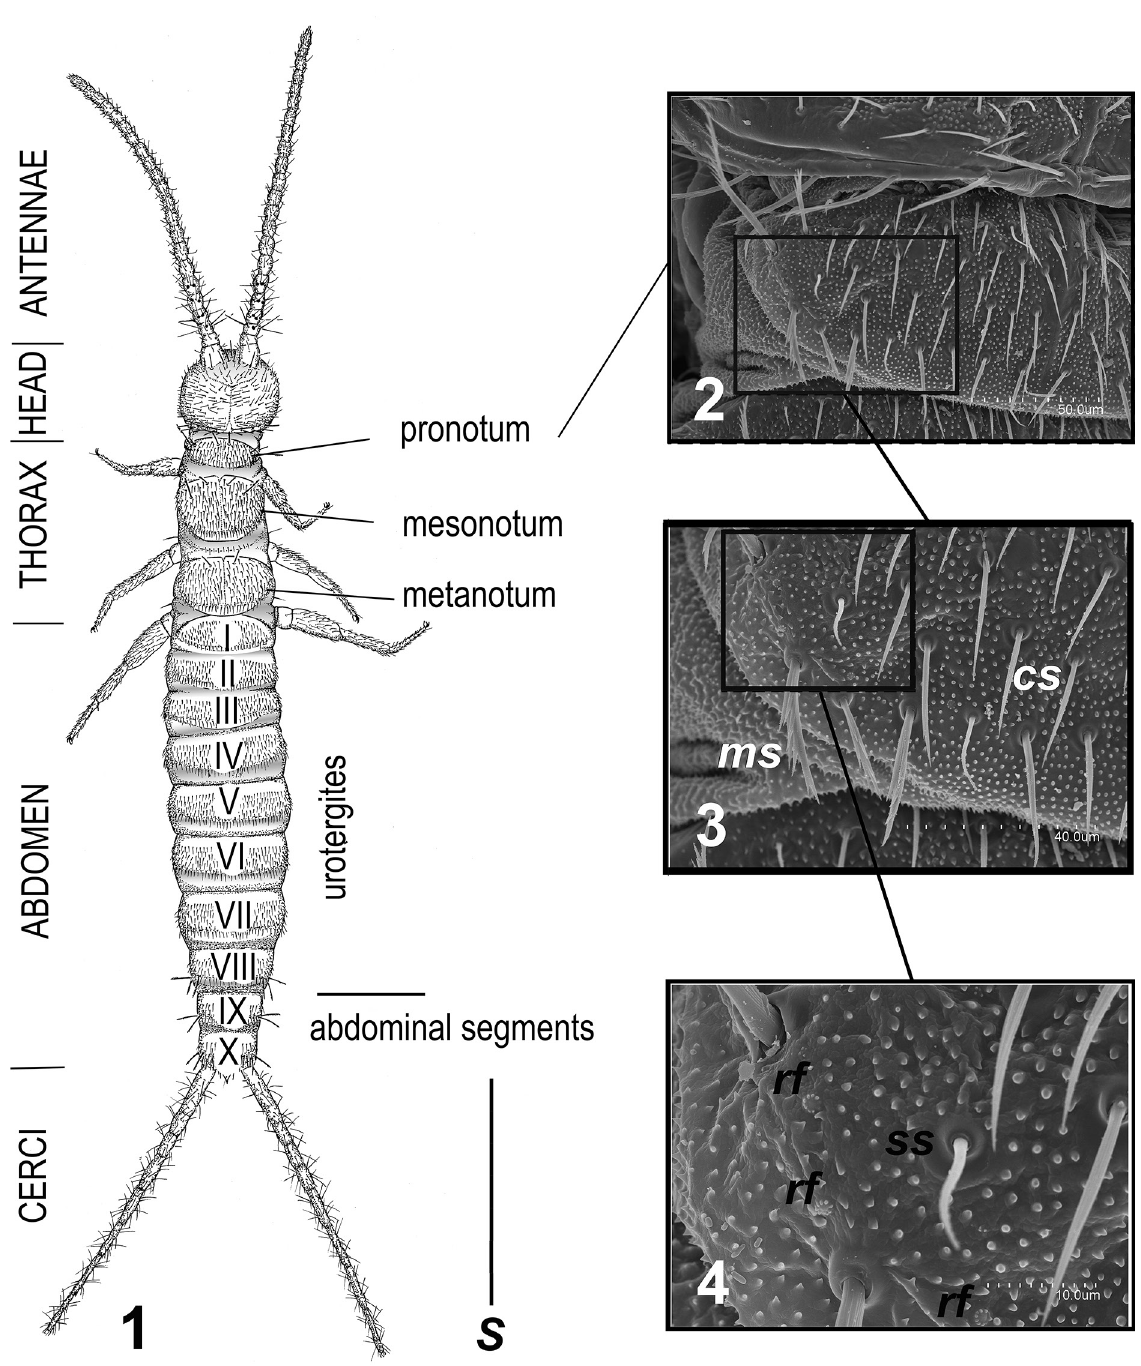
Figs 1–4. Campodea ( Dicampa ) catalana Denis, 1930. 1 . Habitus with terminology of body parts. 2 . Pronotum left side. 3 . Lateral posterior detail of the pronotum left side. 4 . Detail of lateral posterior of the pronotum left heminotum. Abbreviations: see Material and